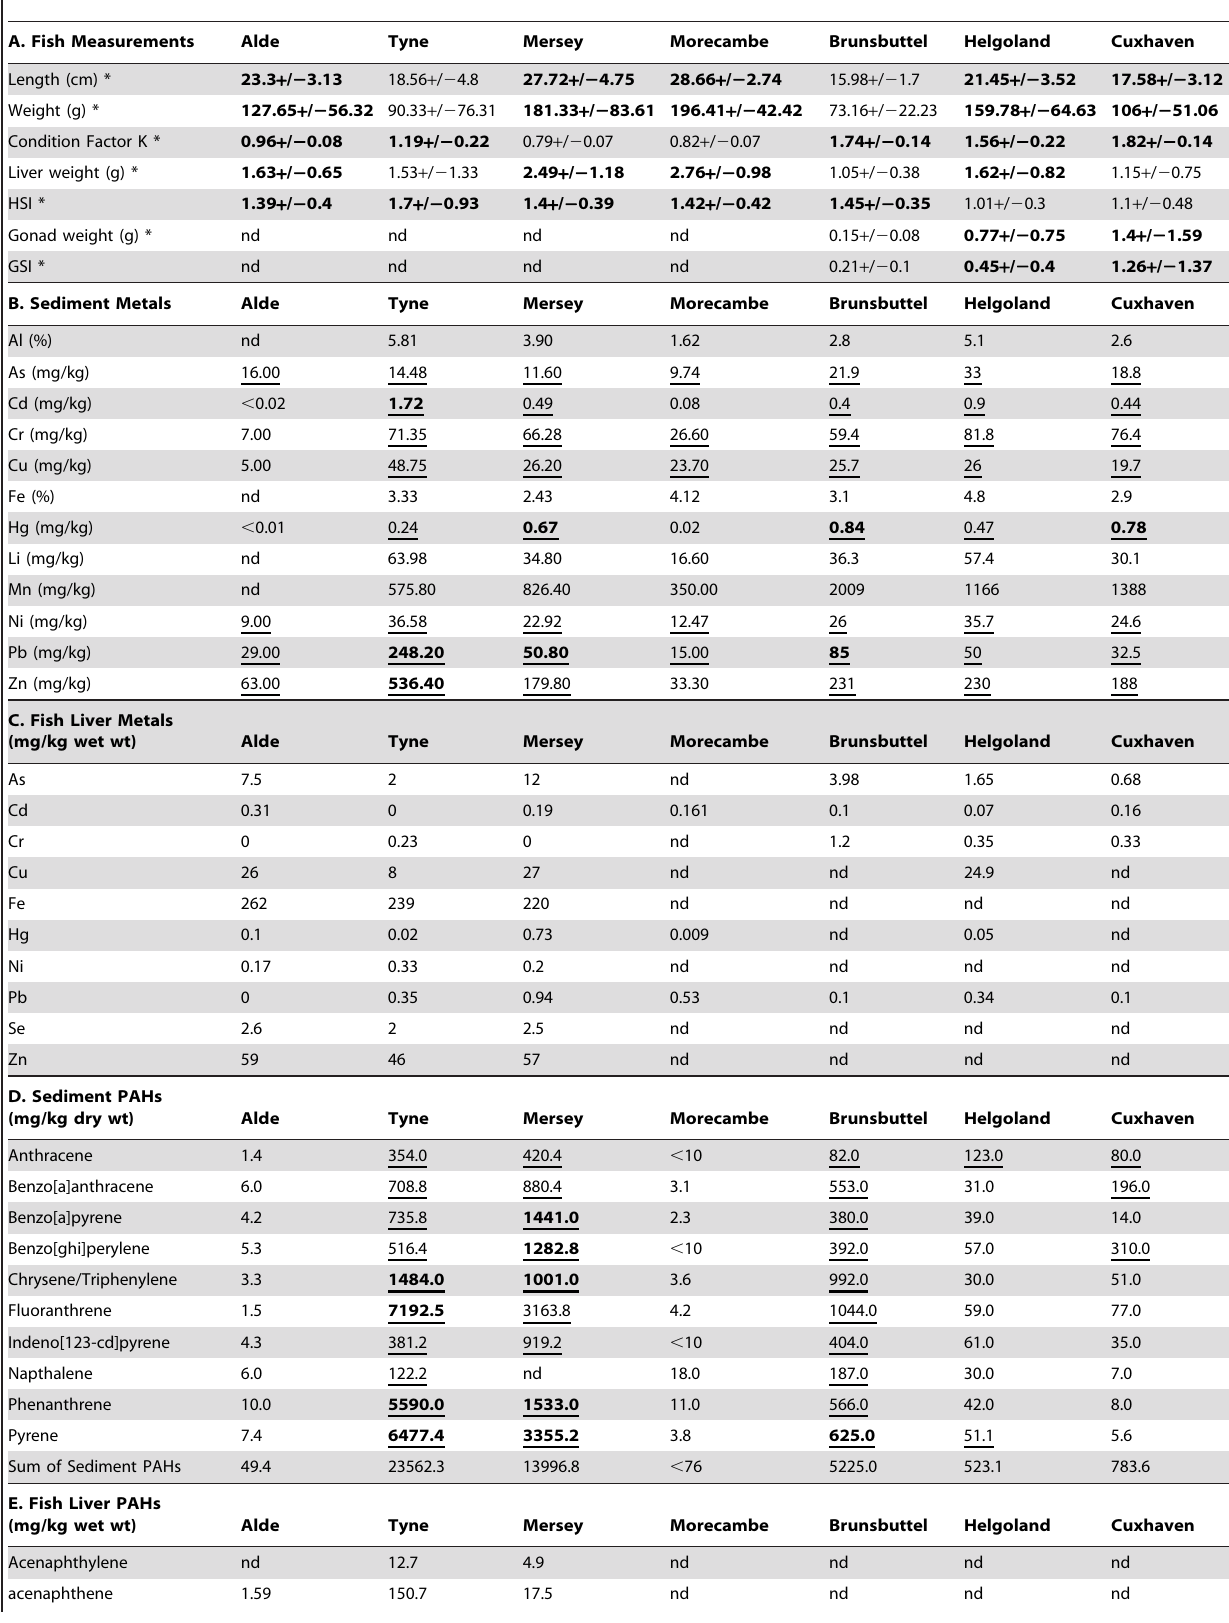
Table 1. Chemistry, fish morphology, histopathology and protein